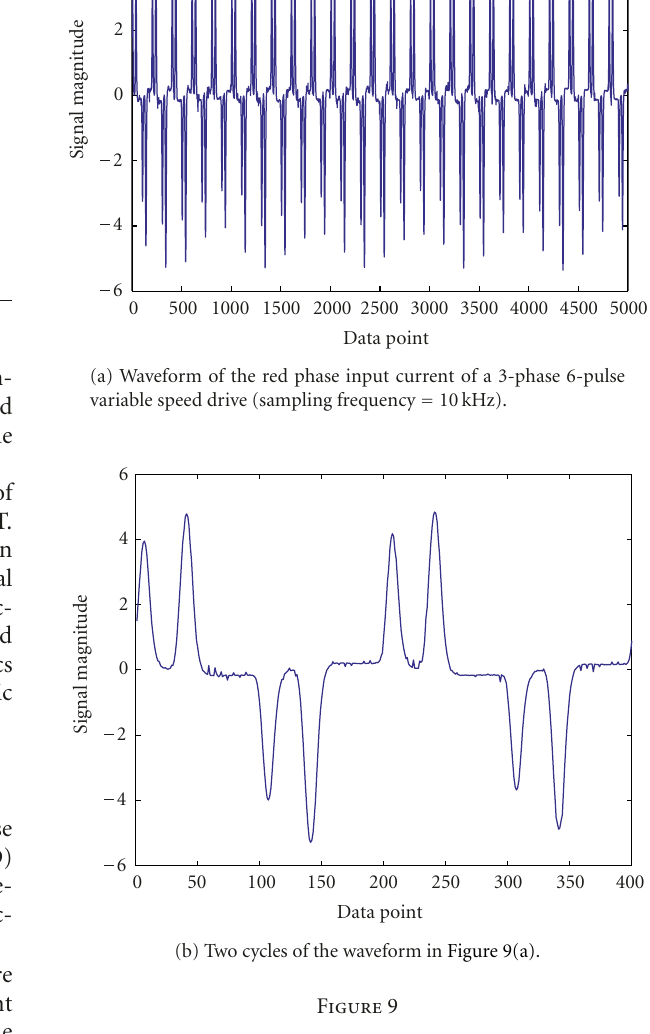
For the proposed harmonics detection algorithm, the harmonics estimated conform to the integer multiples of the fundamental frequency at 49.95 Hz. Some deviations from the integer multiples of the fundamental frequency are how- ever found only at even harmonics which have very small magnitudes. The harmonics estimated by FFT do not conform to the integer multiples of the fundamental frequency estimated at 50 Hz. The errors are possibly due to the comparatively fine frequency resolution of 0.05 Hz. As a result, there are some frequency leakages in the FFT decomposition. The am- plitudes of the harmonics estimated by FFT are therefore smaller than the amplitudes estimated by the proposed har- monic detection